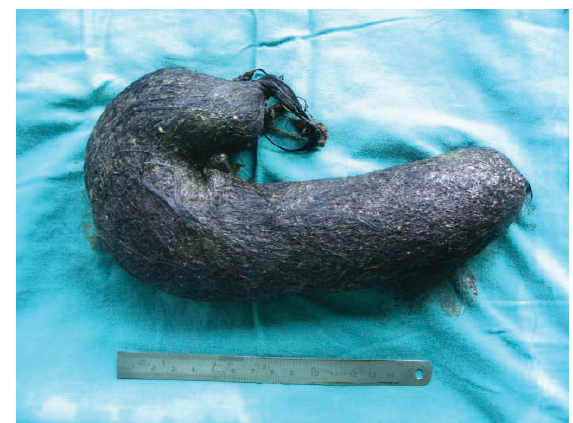
Figure 3. Specimen of extracted gastric trichobezoar with a long